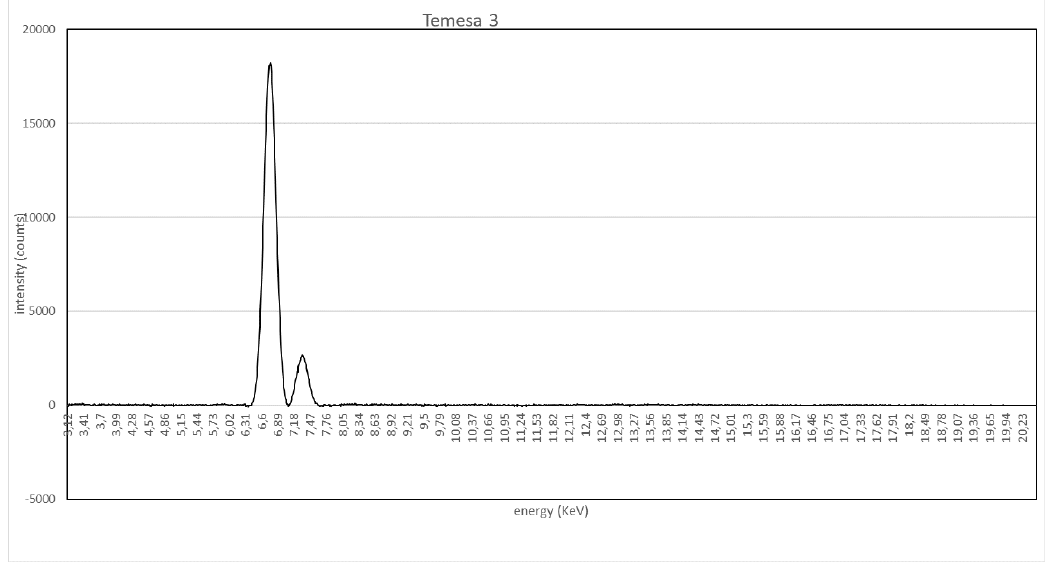
Figure 10. Temesa 3: XRF spectrum.